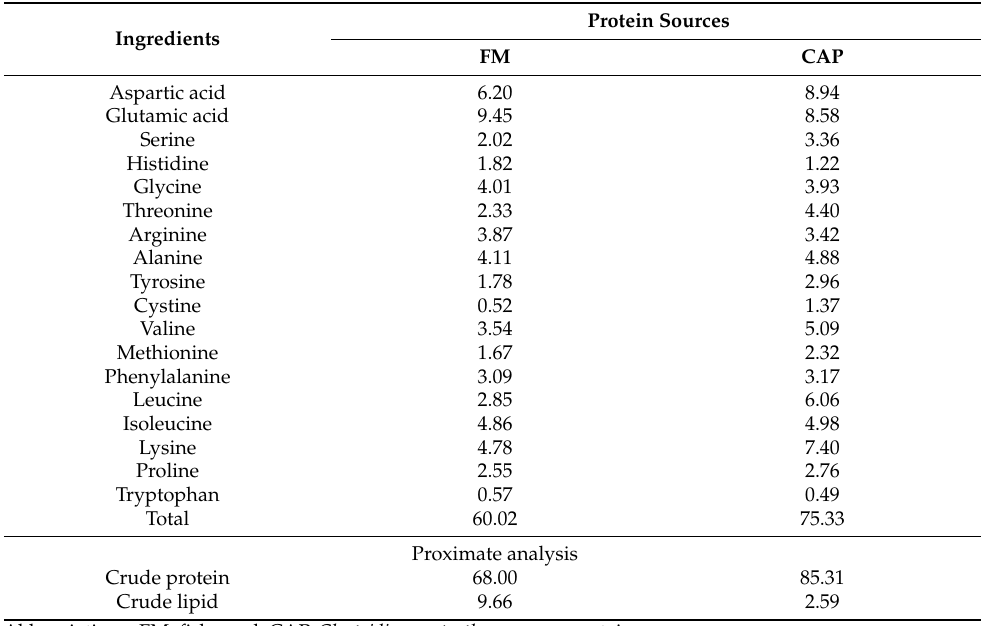
Abbreviations: FM, fish meal; CAP, Clostridium autoethanogenum